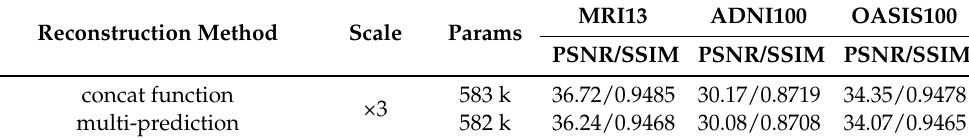
Figure 8. DMFN without the concat function, which degrades into the multi-prediction method. Table 4. Comparison of the concat function and multi-prediction used on DMFN.